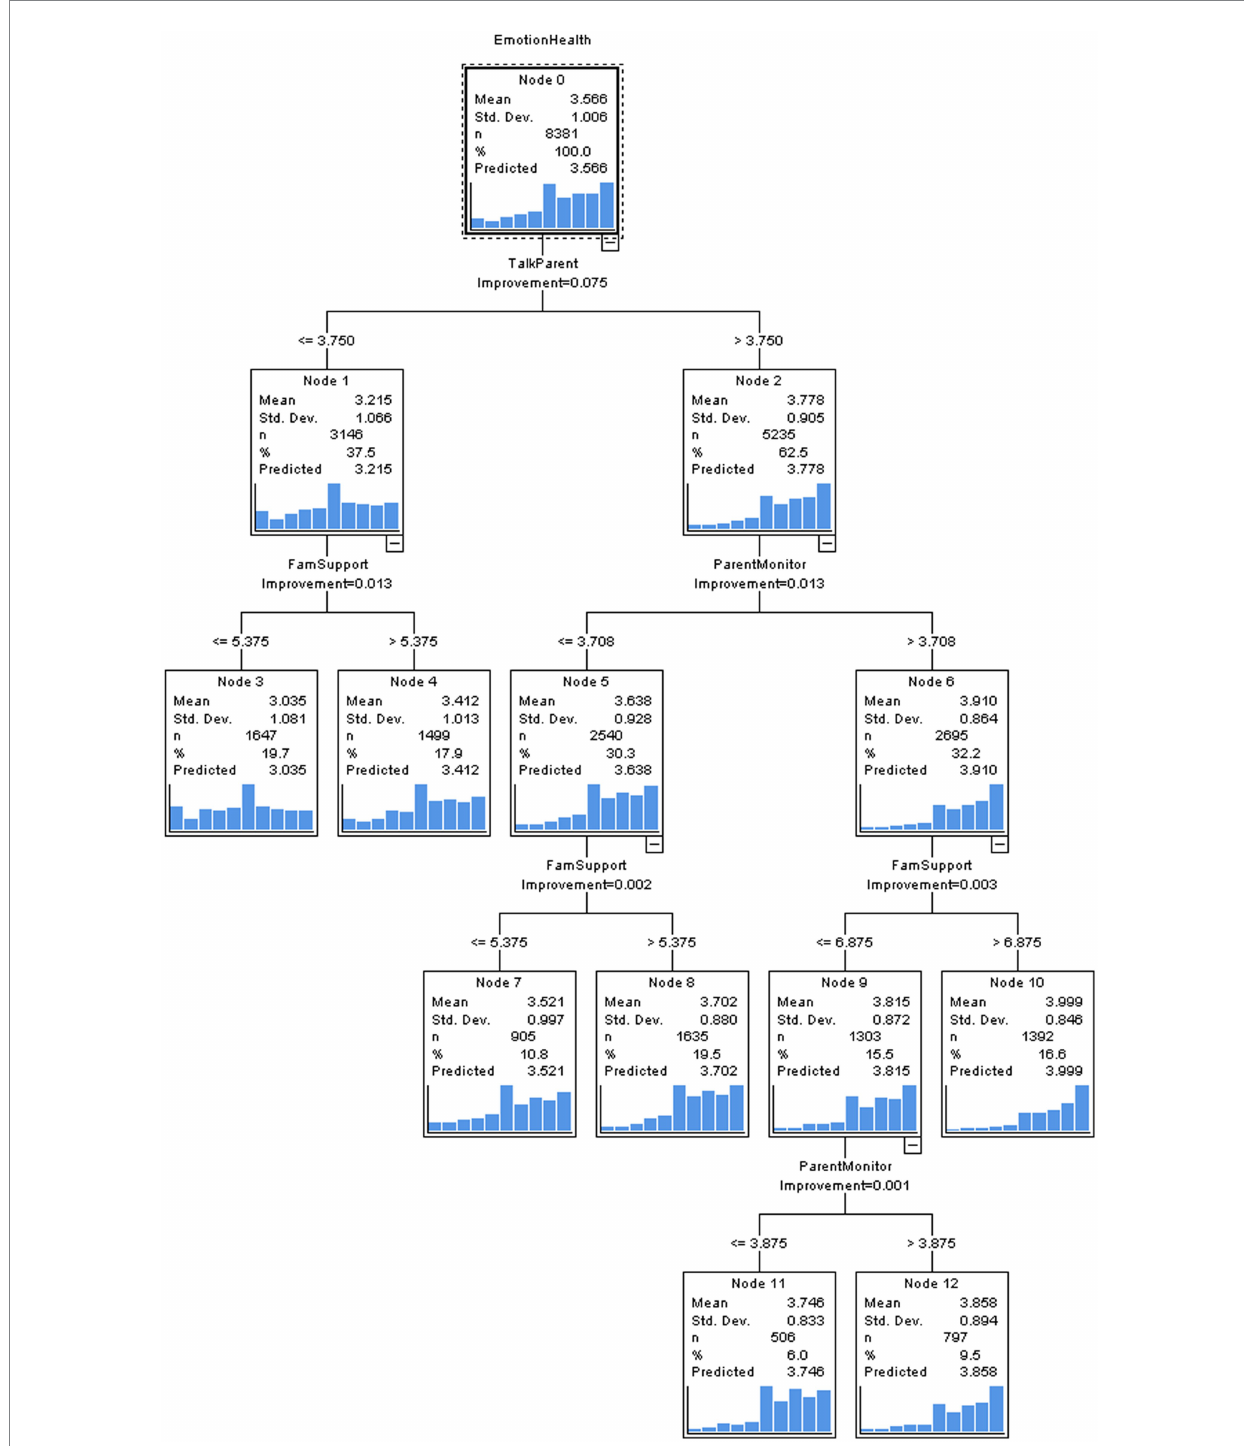
FIGURE 1 The CRT model to predict normally developed adolescents’ emotional health by family-related